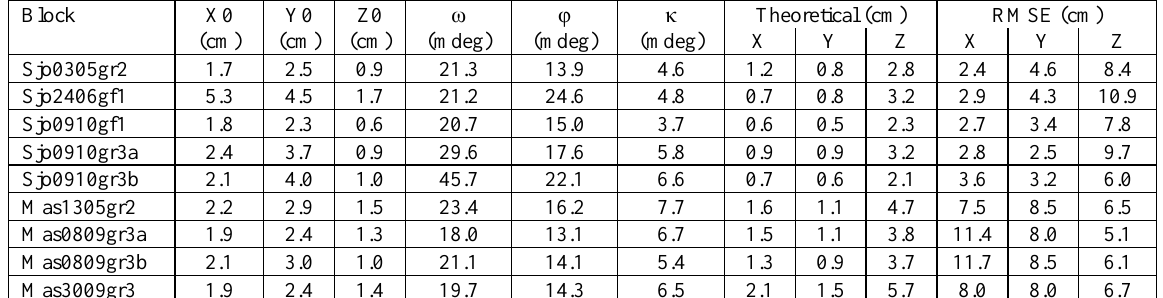
Table 5. Bundle block adjustment statistics: standard deviations of exterior orientation parameters, standard deviations of point unknowns and empirical